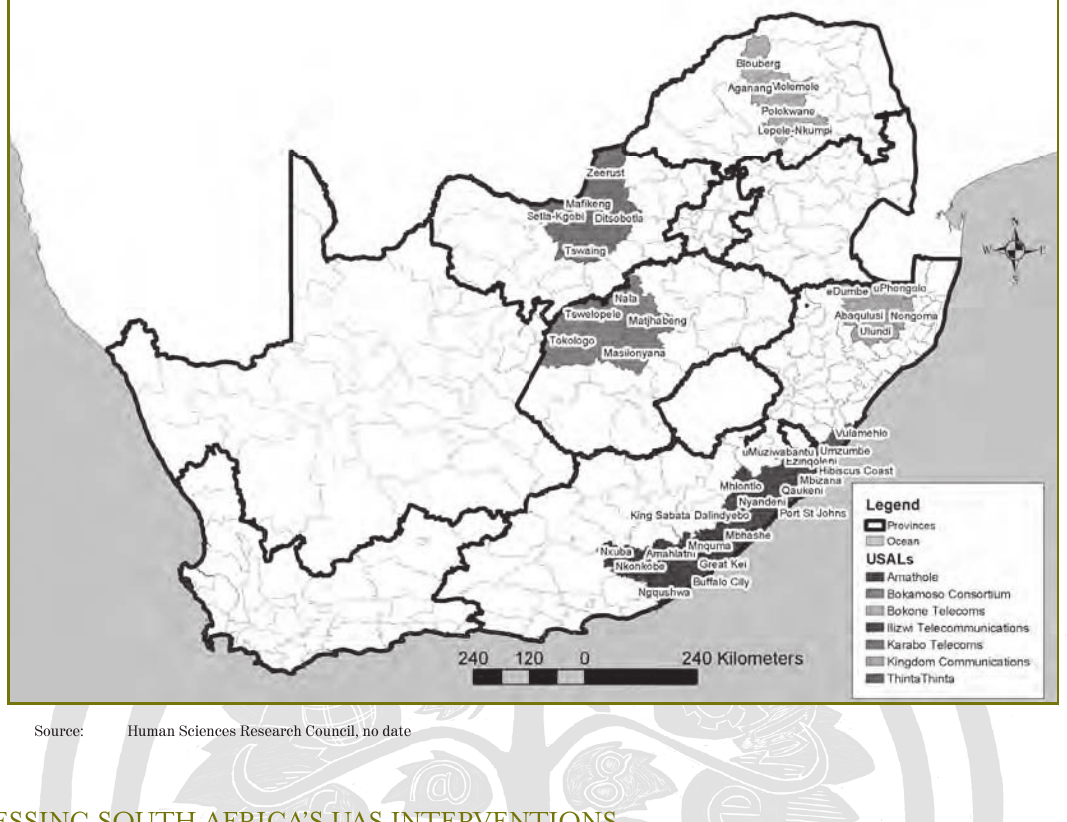
FIGURE 1: FIRST SEVEN UNDER-SERVICED AREA